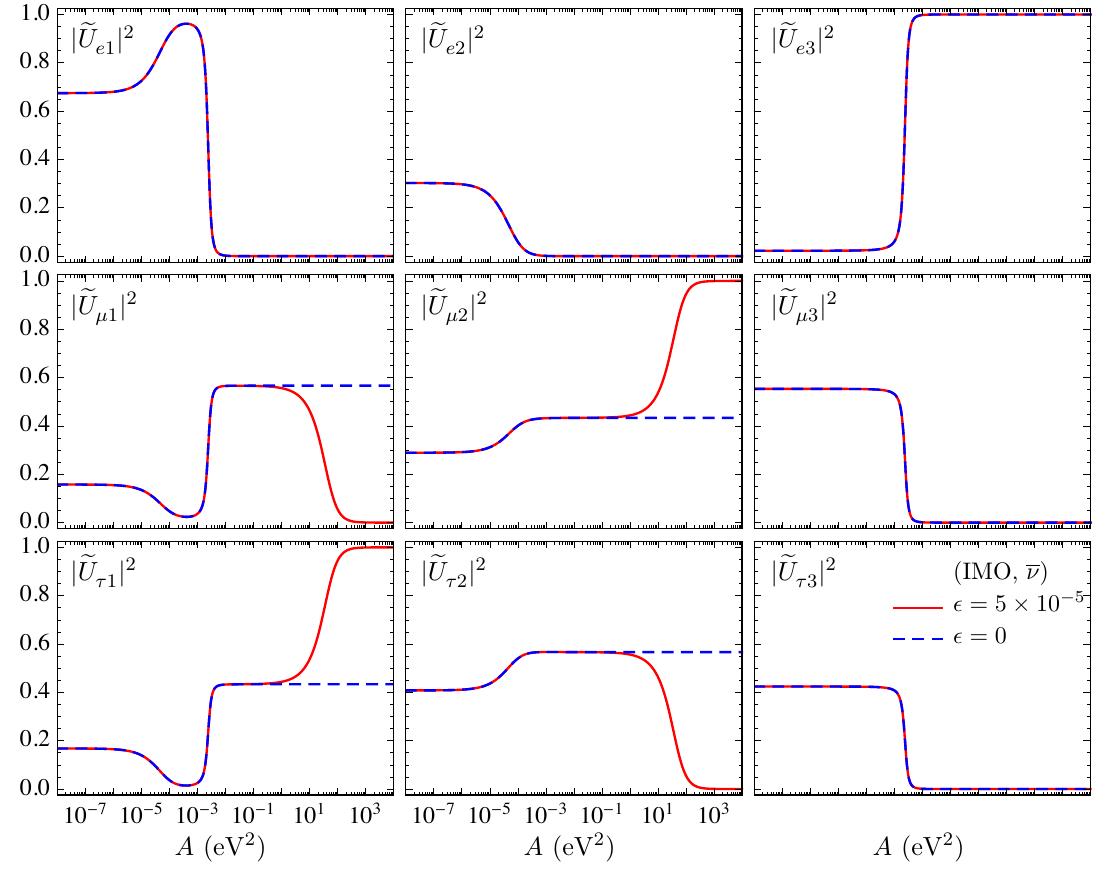
2 (for (cid:11) = e , U (cid:11)i j j e ; (cid:18) ; (cid:18) ; (cid:14); (cid:1) ; (cid:1) ) in refs. [36, 37] have 12 13 23 21 31